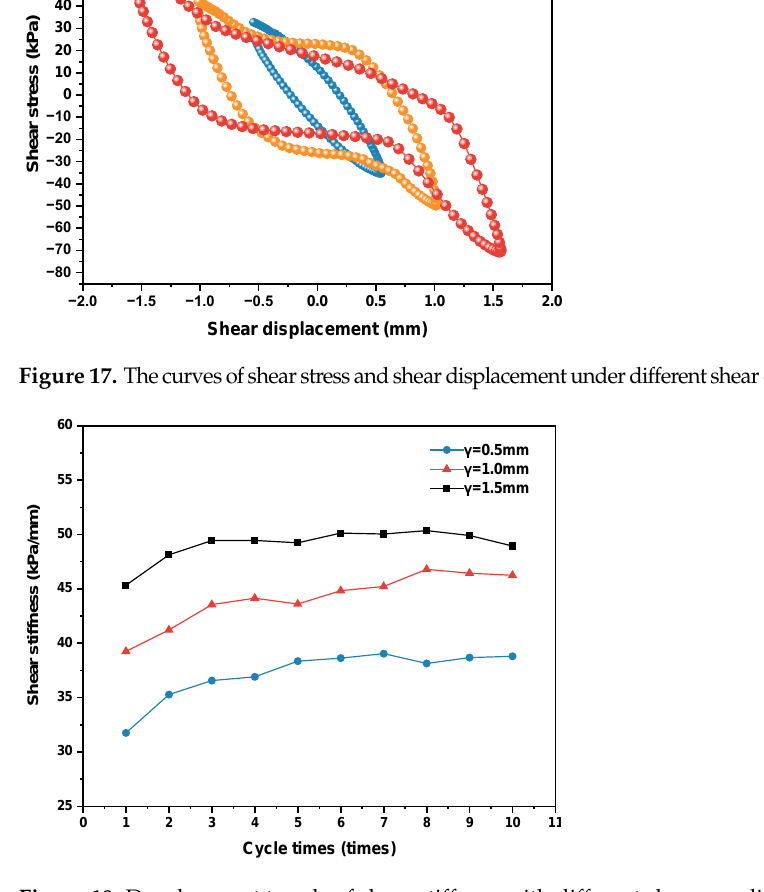
Figure 18. Development trends of shear stiffness with different shear amplitudes.